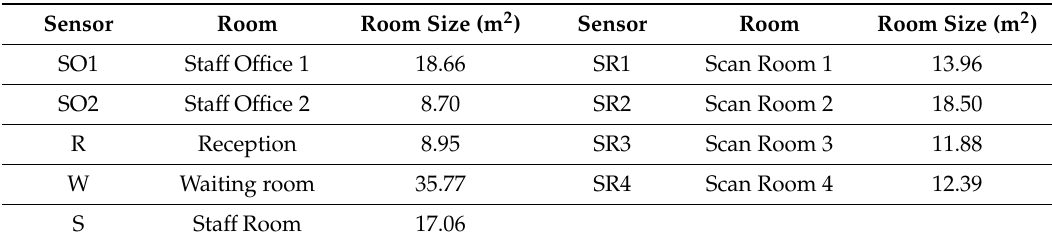
Table 1. Symbols used for sensors, room size and location within the test area. Locations are shown in Figure 2.